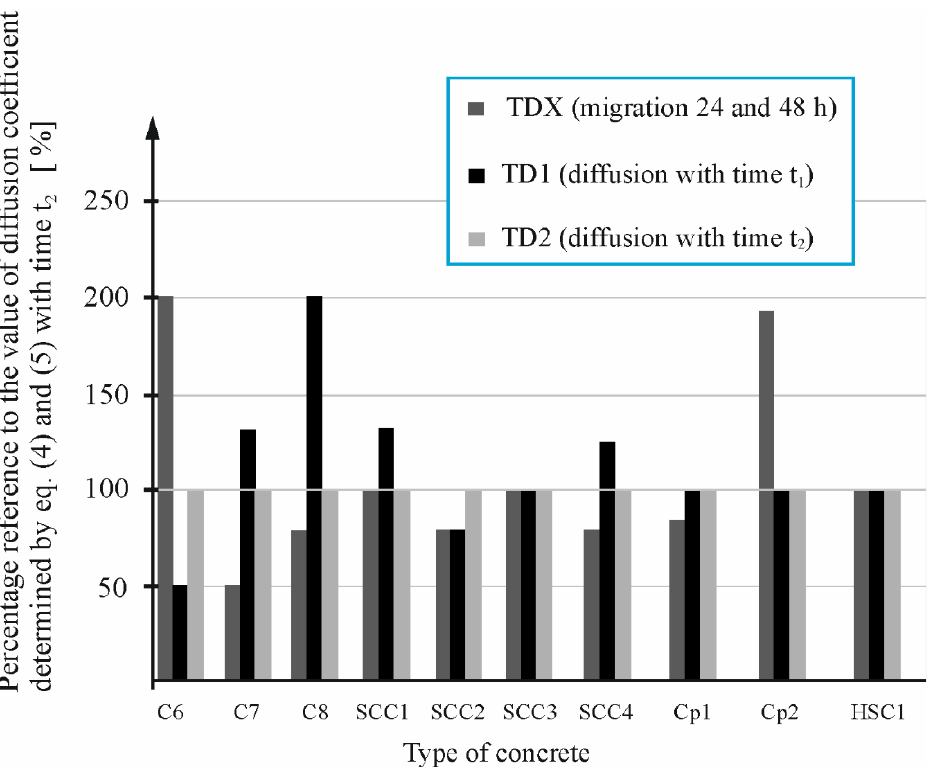
Figure 10. Percentage reference of diffusion coefficient (TDX) and values determined by Equations (4) and (5) at time t 1 (TD1) and time t 2 (TD2) to the reference value determined at time t 2 (TD2): in C6-C8, SCC1 -SCC4, Cp1, Cp2,HSC1 concretes.